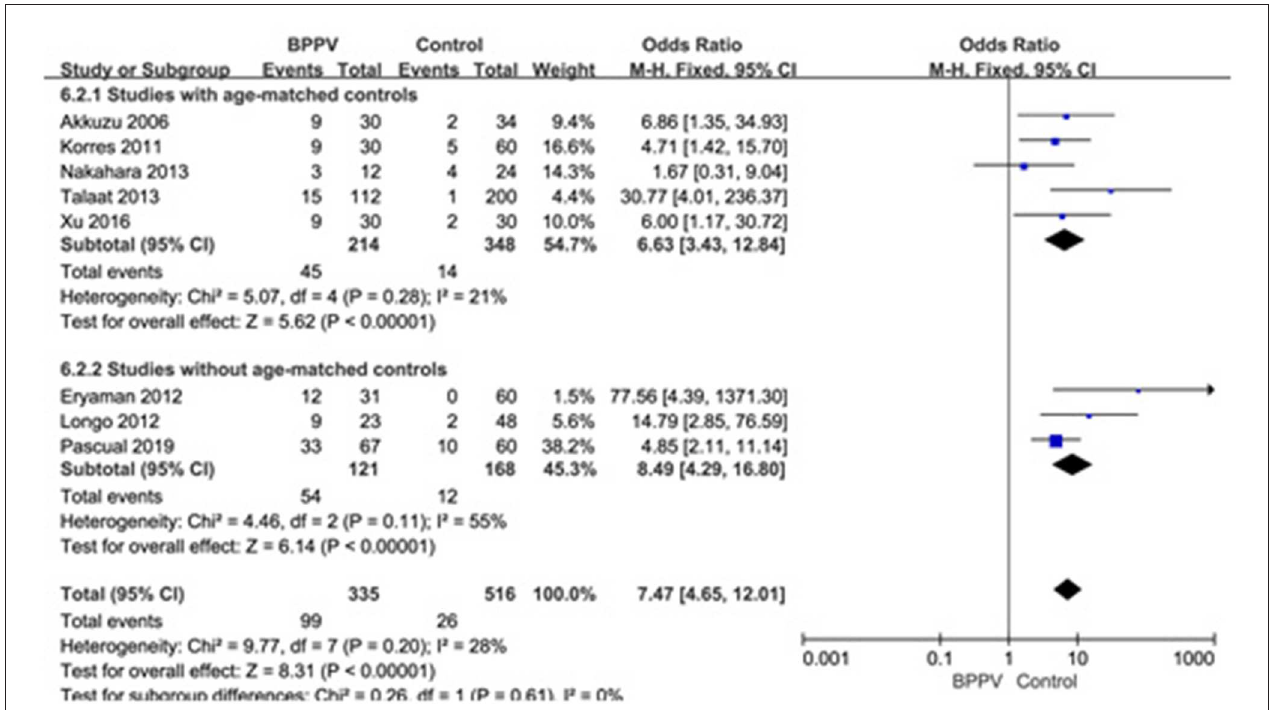
FIGURE 7 | Forest plots of subgroup meta-analysis of proportion of abnormal cVEMP based on whether or not the age matches between BPPV and healthy groups. BPPV, benign paroxysmal positional vertigo; cVEMP, cervical vestibular evoked myogenic